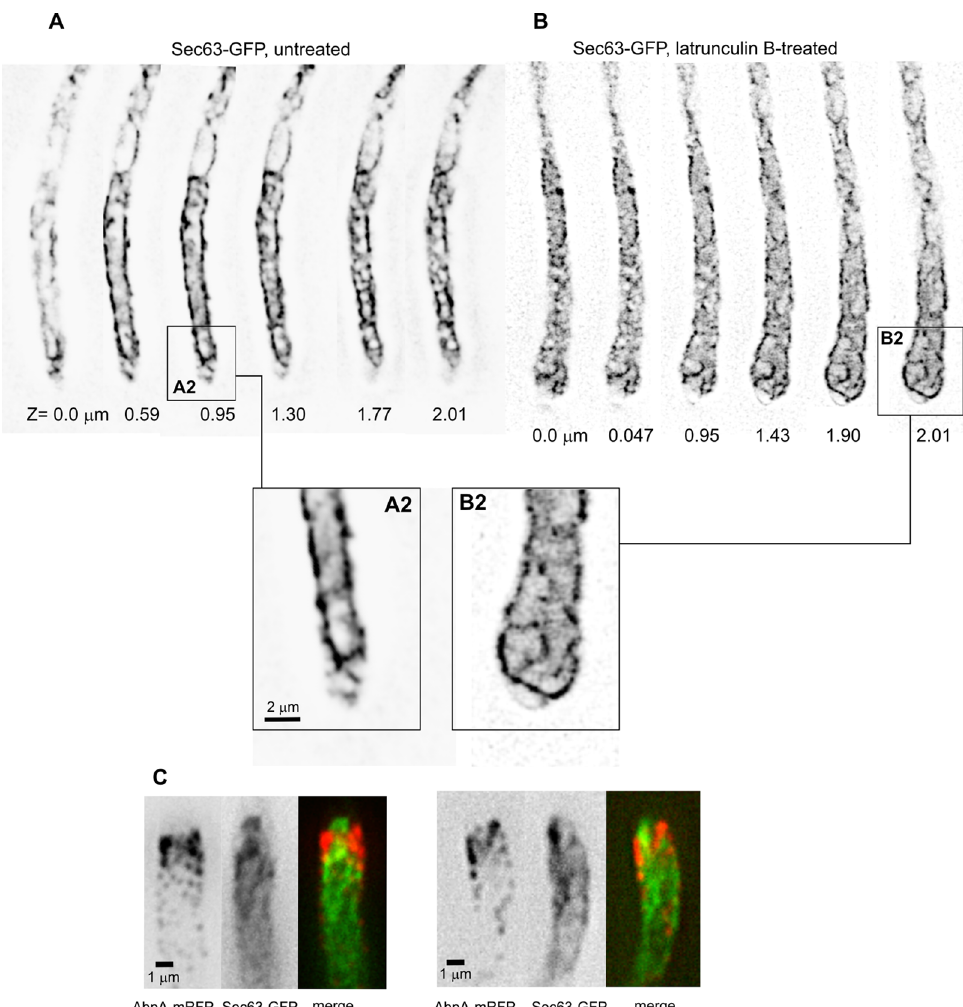
Figure 4. Role of F-actin and of the subapical collar of actin patches in determining peripheral ER morphology. A. Individual images of a z-stack of Sec63-GFP in an untreated hyphal tip cell control. B. Individual images of a z-stack of Sec63-GFP in a hyphal tip cell treated with latrunculin B. A2 and B2 correspond to the rectangular regions indicated in A and B , respectively, shown at double magnification. C. Dual-channel images of Sec63-GFP and mRFP-AbpA. Two examples of hyphal tip cells are shown. Images represent maximal intensity projections of z-stacks treated with an ‘unsharp’ filter.